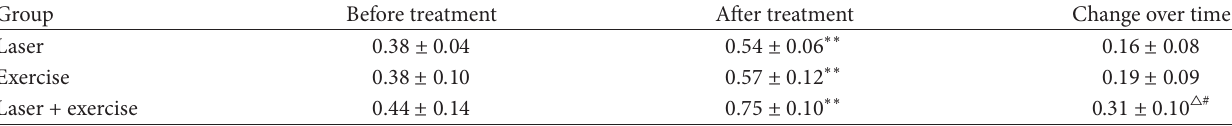
Laser + exercise 0.44 ± 0.14 0.31 ± 0.10 △ # Values are expressed in kg/kg body weight. Asterisks indicate significant differences from pretreatment ( ∗∗ 𝑃 < 0.01 ). Triangles indicate significant differences